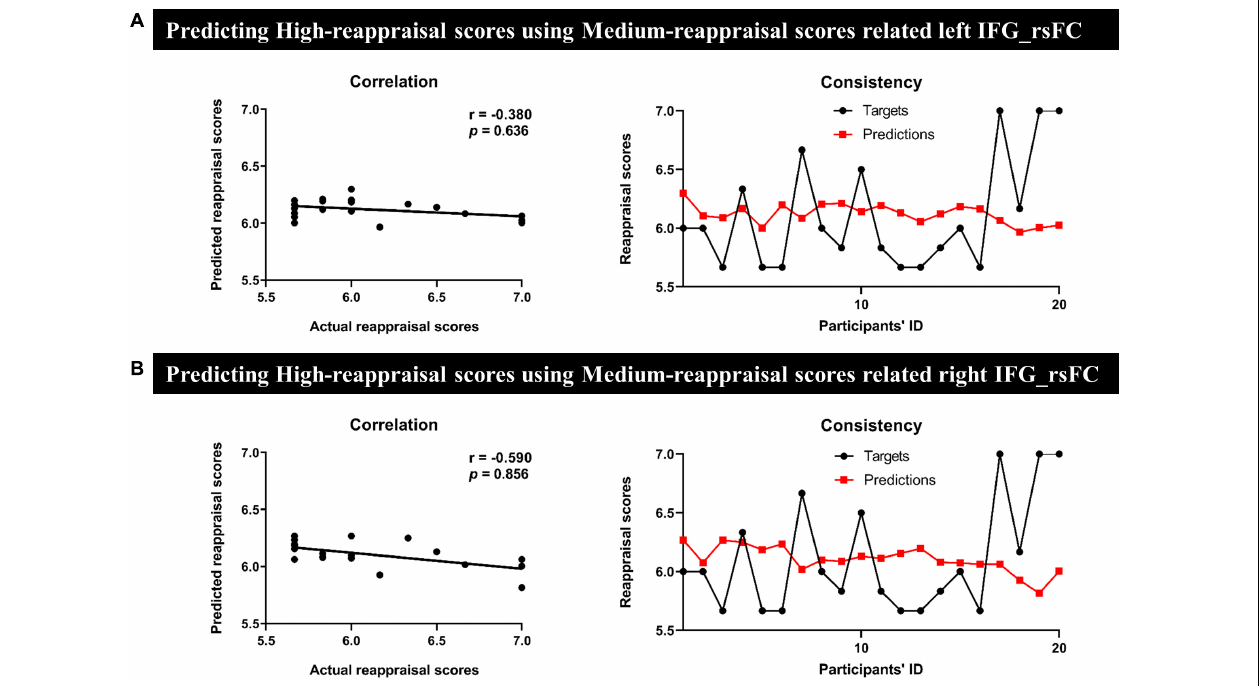
FIGURE 5 | Results of prediction between HRG and sMRG. We separately used (A) the left and (B) the right IFG-based rsFC of sMRG to predict the reappraisal scores of HRG. Scatter plots and line charts indicated non-significant correlation and consistency between actual and predicted reappraisal scores,